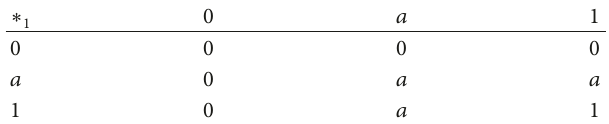
Table 2: Binary operation ∗ 2 subject to 𝑄 󸀠 𝑡